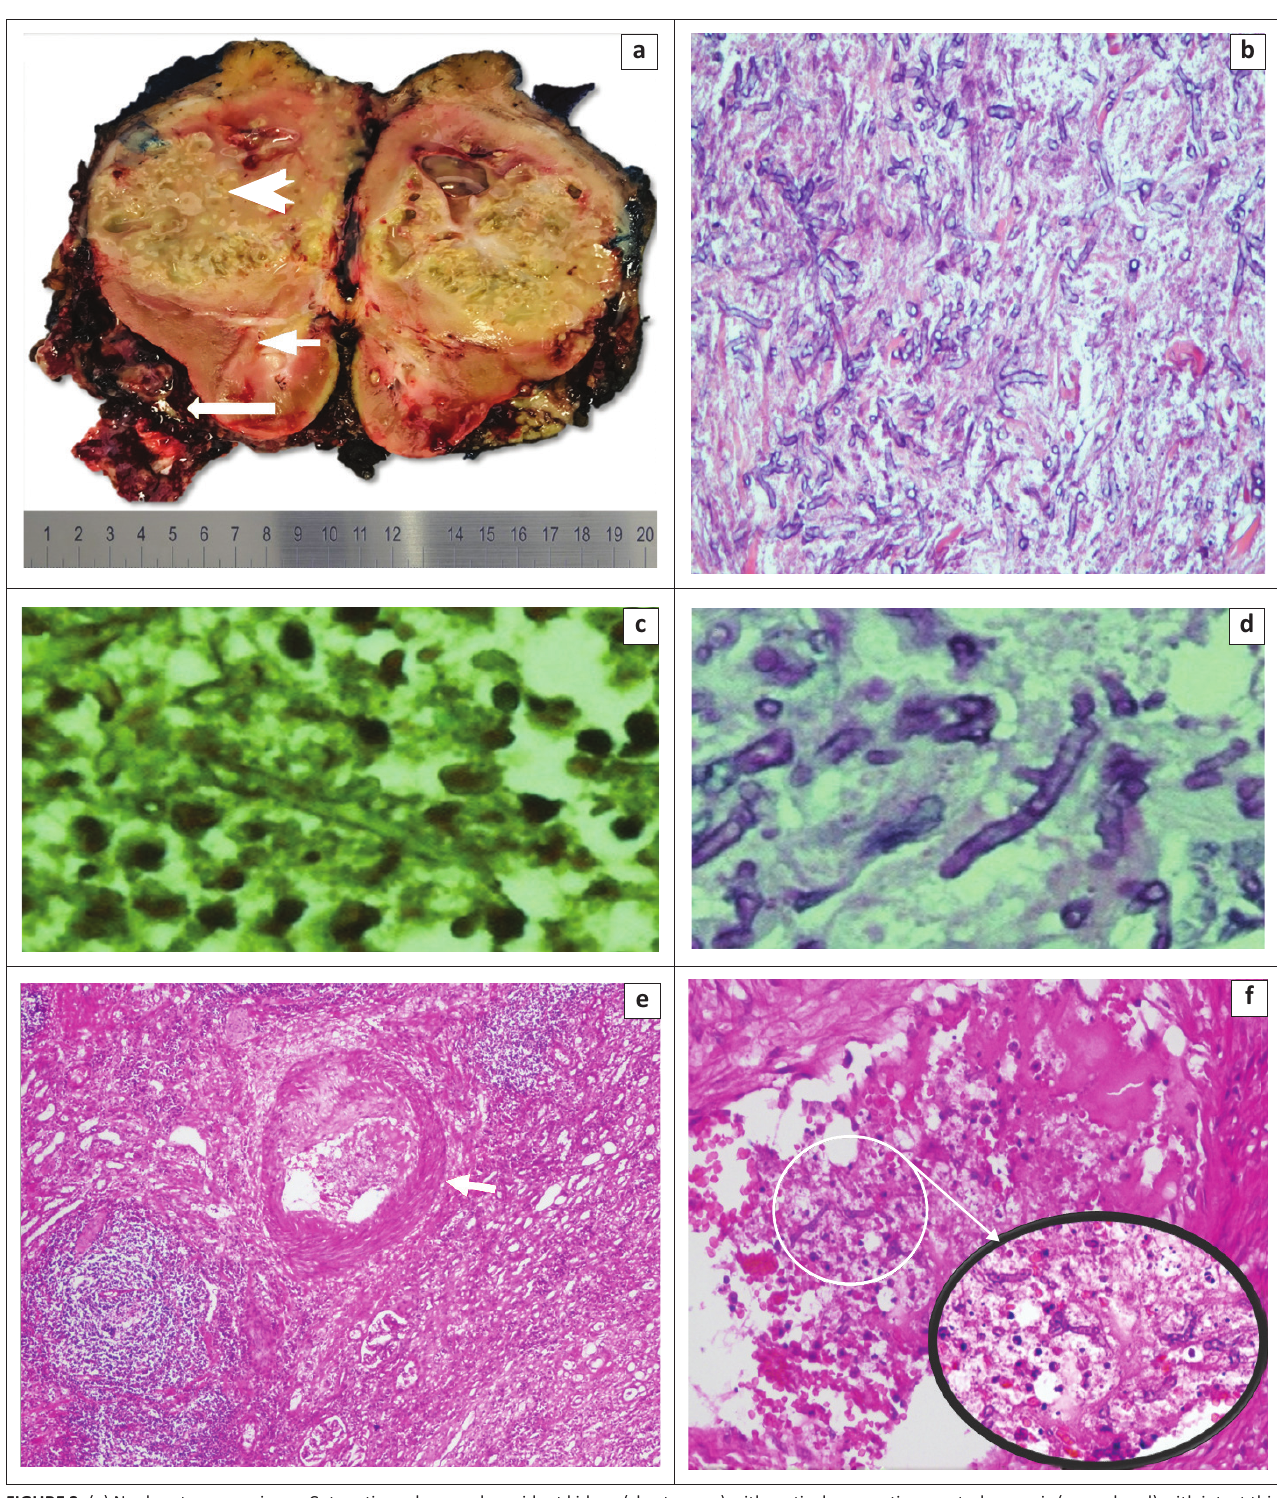
FIGURE 2 : (a) Nephrectomy specimen. Cut sections shows pale resident kidney (short arrow) with cystic degeneration, central necrosis (arrow head) with intact thin capsule that contain pus and necrotic material (long arrow); (b) Haemotoxylin and Eosin (H&E) stained sections show necrotic background with broad-based aseptated fungal hyphae with right-angle branching (×4 magnification); (c and d) (histochemical stain, 20× magnification). (c) Gomori methenamine silver (grocott) and (d) Periodic acid schiff (PAS) highlights the fungal hypae; (e) (×4 magnification) and (f) (×20 magnification and insertion at ×50 magnification) show fungal